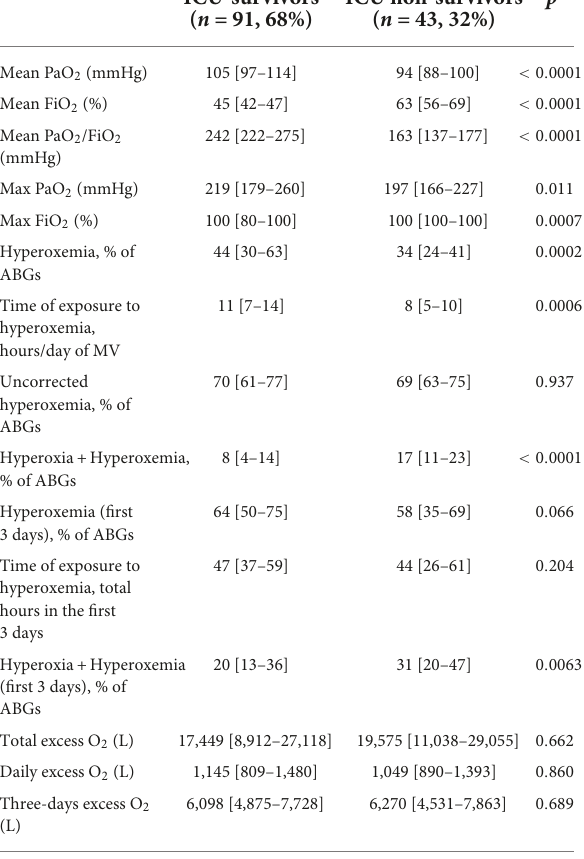
TABLE 3 Comparison of oxygenation variables between ICU-survivors and Non-survivors.